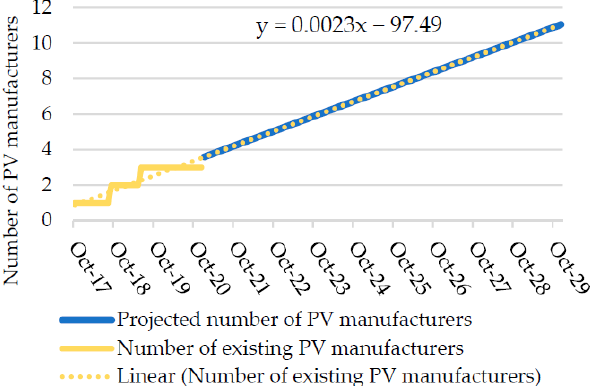
Figure 3. Cumulative number of registered PV manufacturers on the REPDO portal [12] (gold line), the linear equation that fits the number of registered manufacturers (gold dots) and the projected number of registered PV manufacturers based on the trendline equation (blue line).